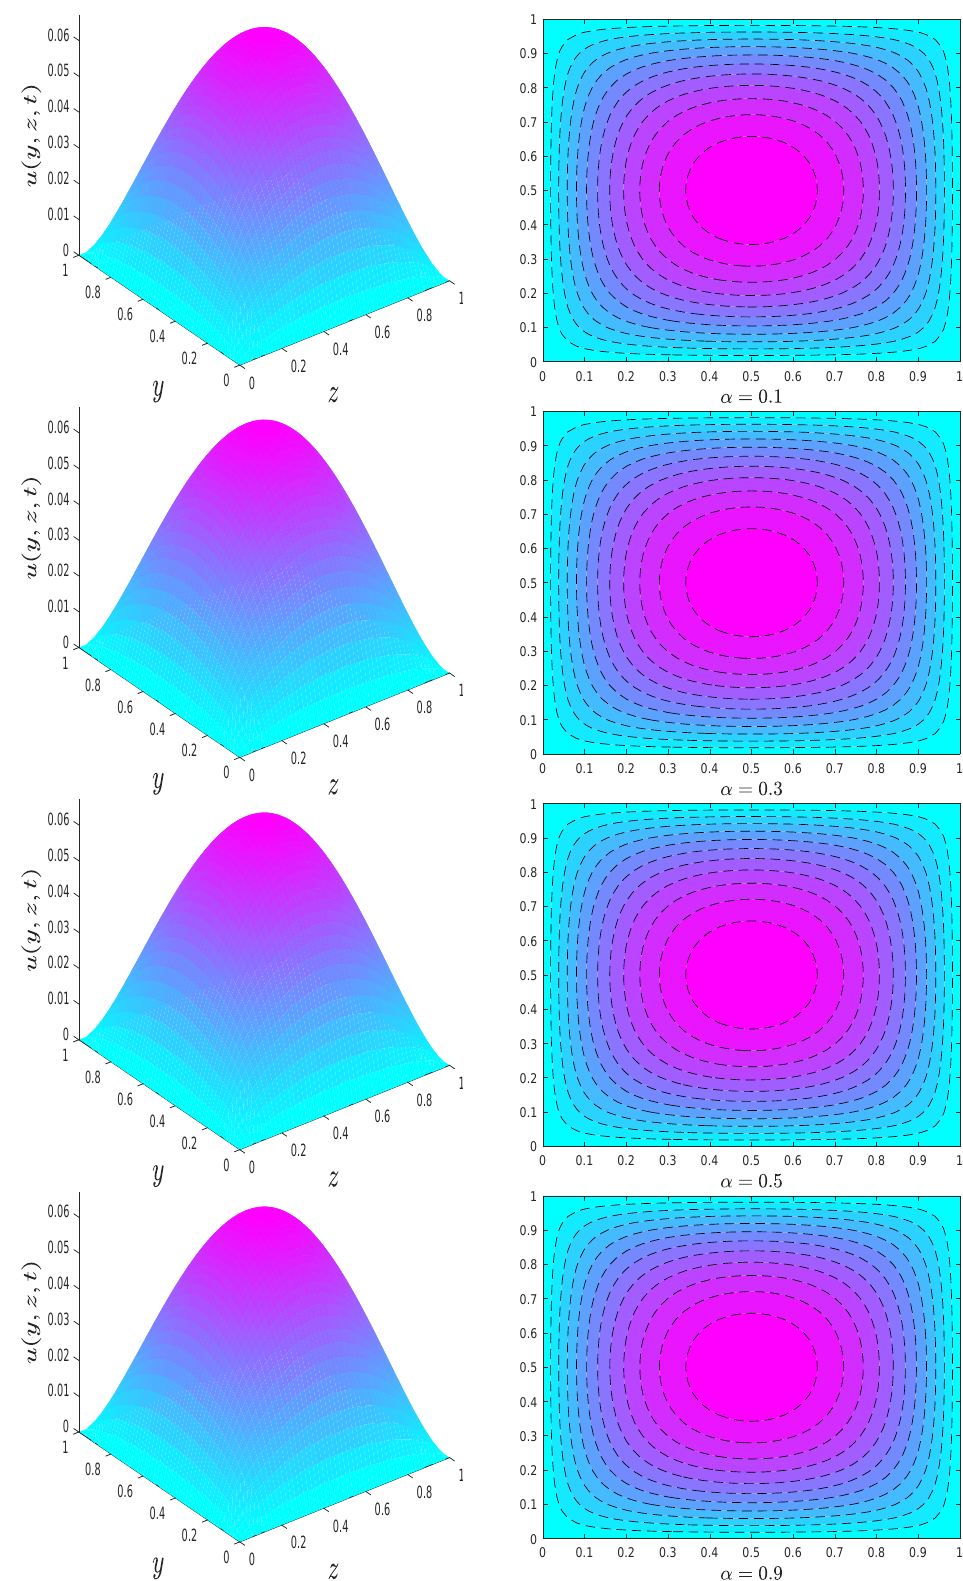
Figure 4. Velocity profile for different values of fractional derivative parameter α